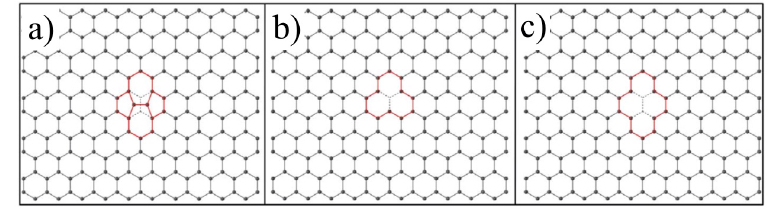
Figure 6. Schematic illustration of several types of defects present in graphene: ( a ) Stone–Wales; ( b ) mono-vacancy; and ( c ) di-vacancy. Reprinted with permission from ref. [109]. Copyright 2018 Elsevier. Grain boundaries are linear defects that can form due to the accumulation of